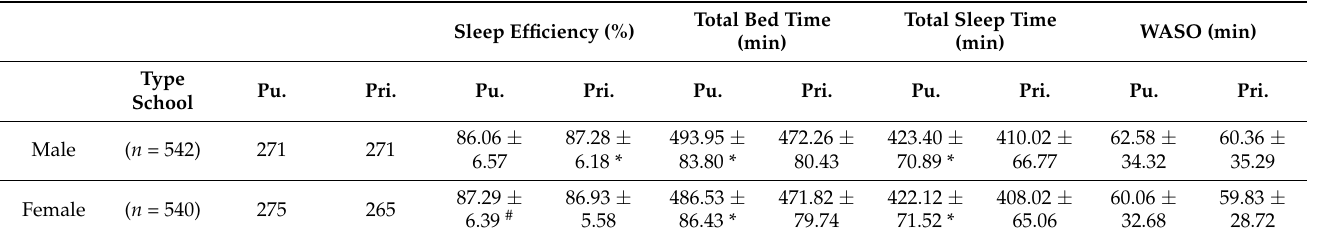
Table 6. Results of sleep quality variables on the basis of centre ownership and sex as independent variables of analysis. Sleep Efficiency (%)